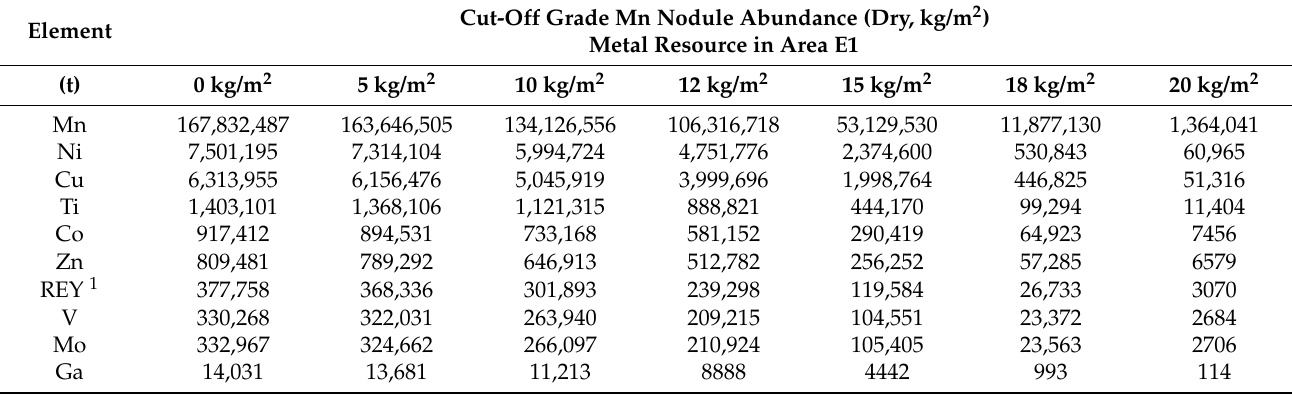
Table 4. Overview of the estimated metal resources in Area E1 at different cut-off values (based on dry weight). Cut-Off Grade Mn Nodule Abundance (Dry, kg/m 2 ) Element Metal Resource in Area E1